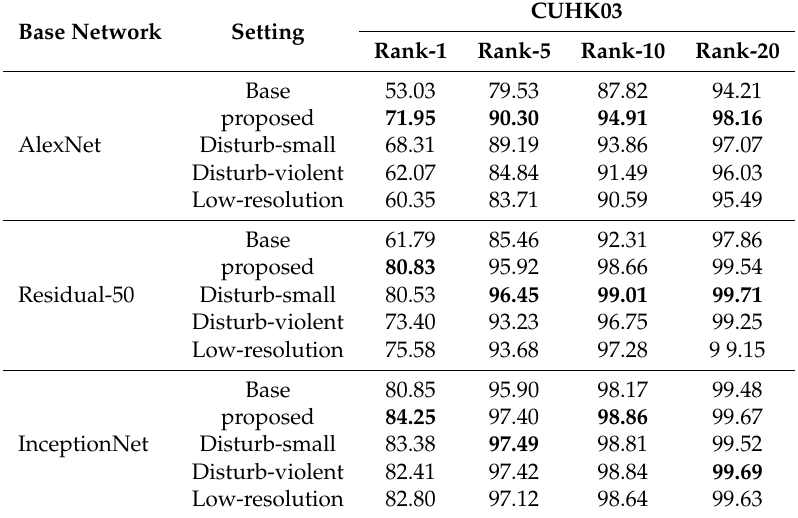
Table 7. Identification accuracy (%) of the proposed method with different base networks on CUHK03 when different disturbances were applied to the segmented body parts and when low resolution images were used. The best results under different settings are marked in